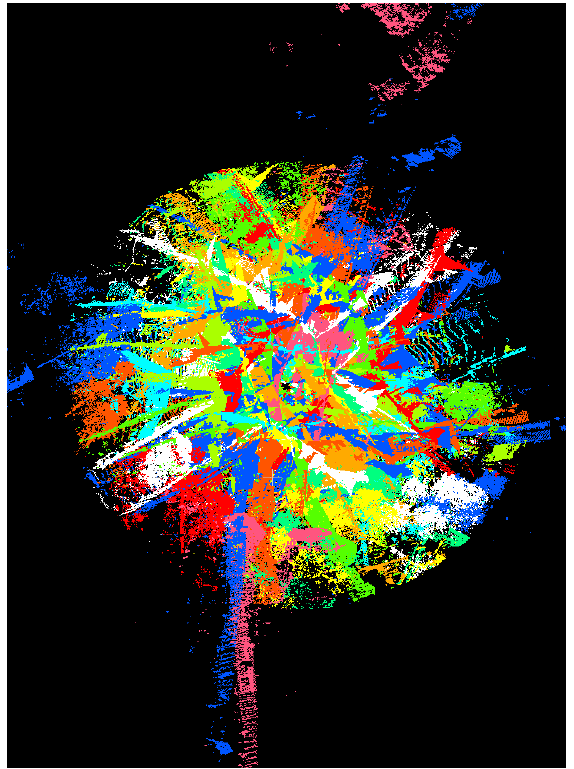
Figure 9. Twelve point clouds of Holzmarkt dataset before registration (each point cloud with a random color)